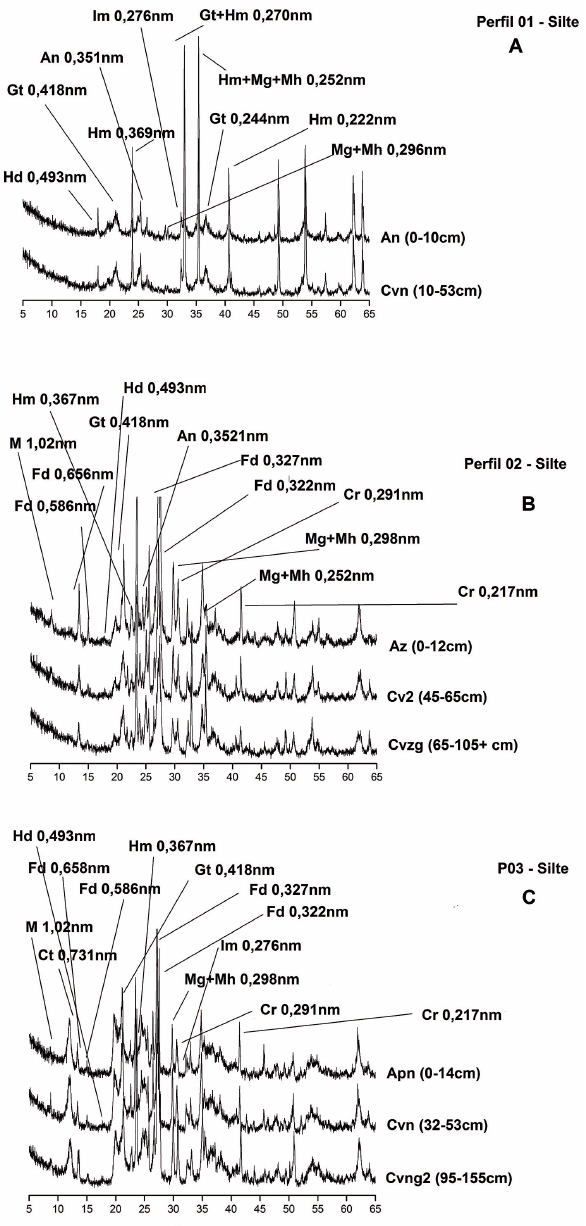
Figura 1. Difratogramas de raios-X da fração silte dos Vertissolos de Fernando de Noronha, PE, estudados (Fd-feldspato; M-mica; Ct-caulinita; Gt-goethita; Hm-hematita; Im-ilmenita; Mg- magnetita; Mh-maghemita; Cr-crandalita; An– anatásio; e